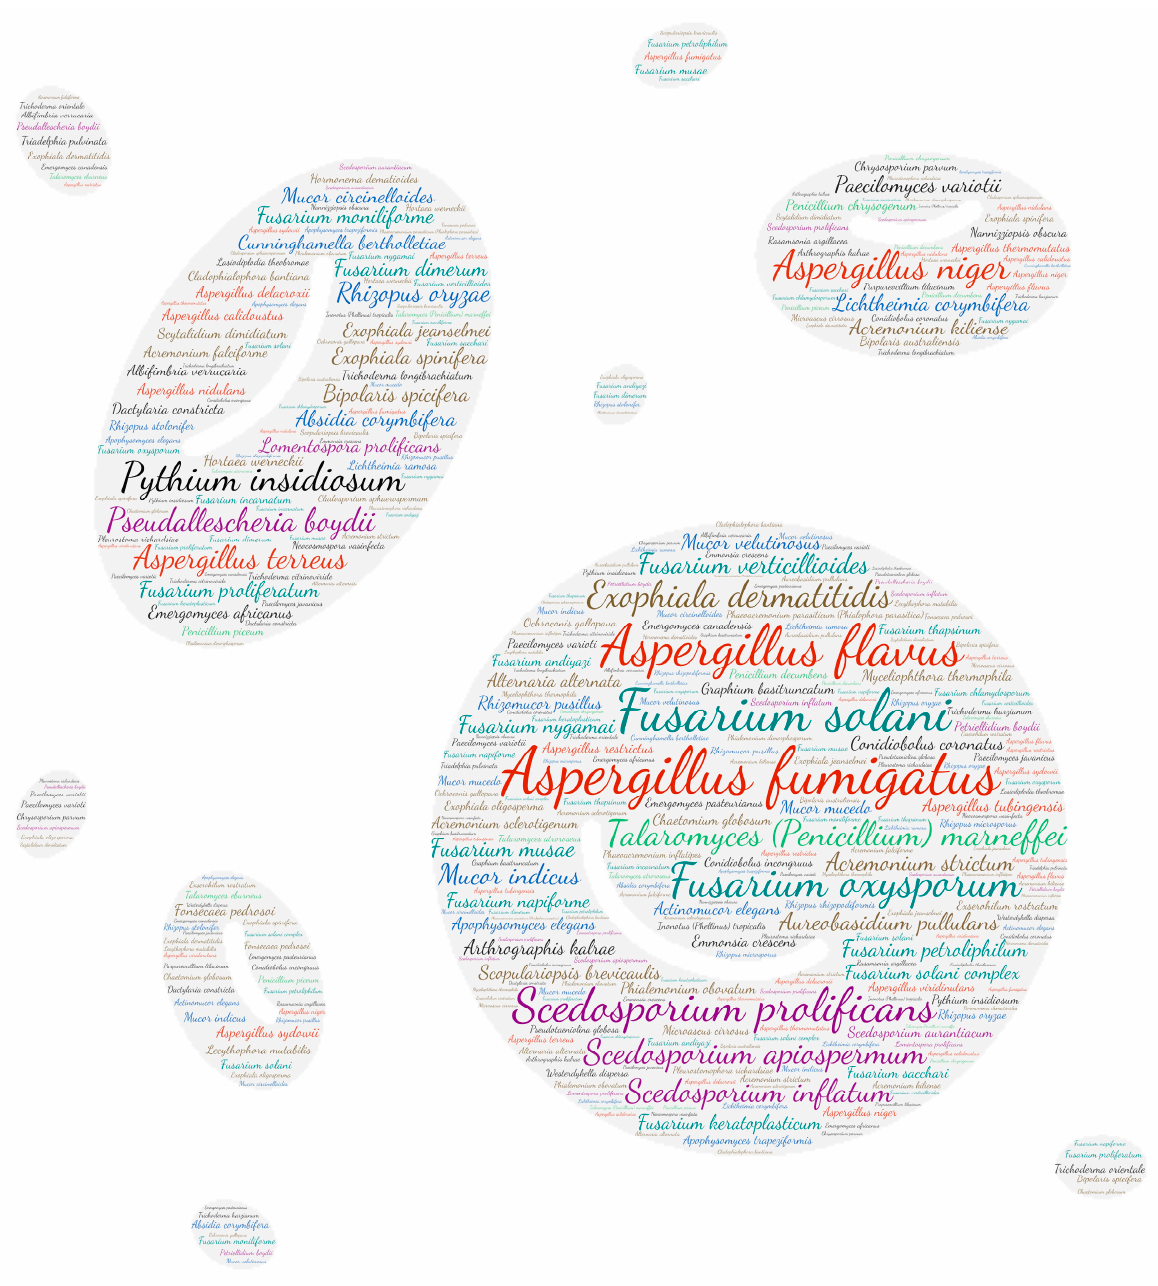
Figure 2. Wordcloud represents the species name involved in systemic infections. The size of the name of each species is proportional to the number of times it occurs in the repertoire.